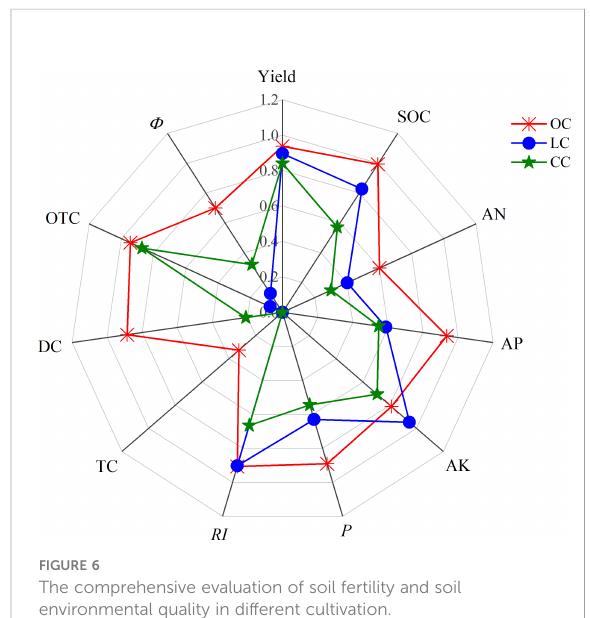
FIGURE 6 The comprehensive evaluation of soil fertility and soil environmental quality in different cultivation.